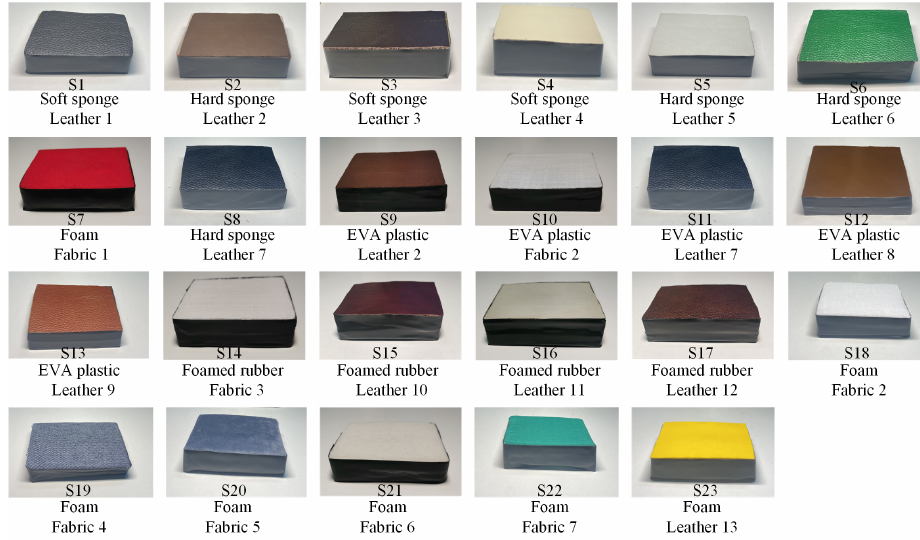
Figure 2. The twenty-three samples used in this paper.